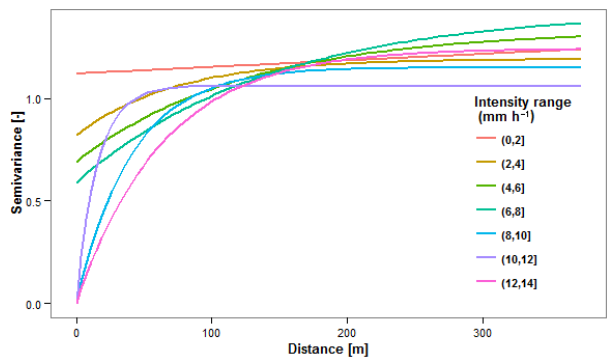
Figure 8. Calculated variograms for a narrower range of intensity at 5min averaging